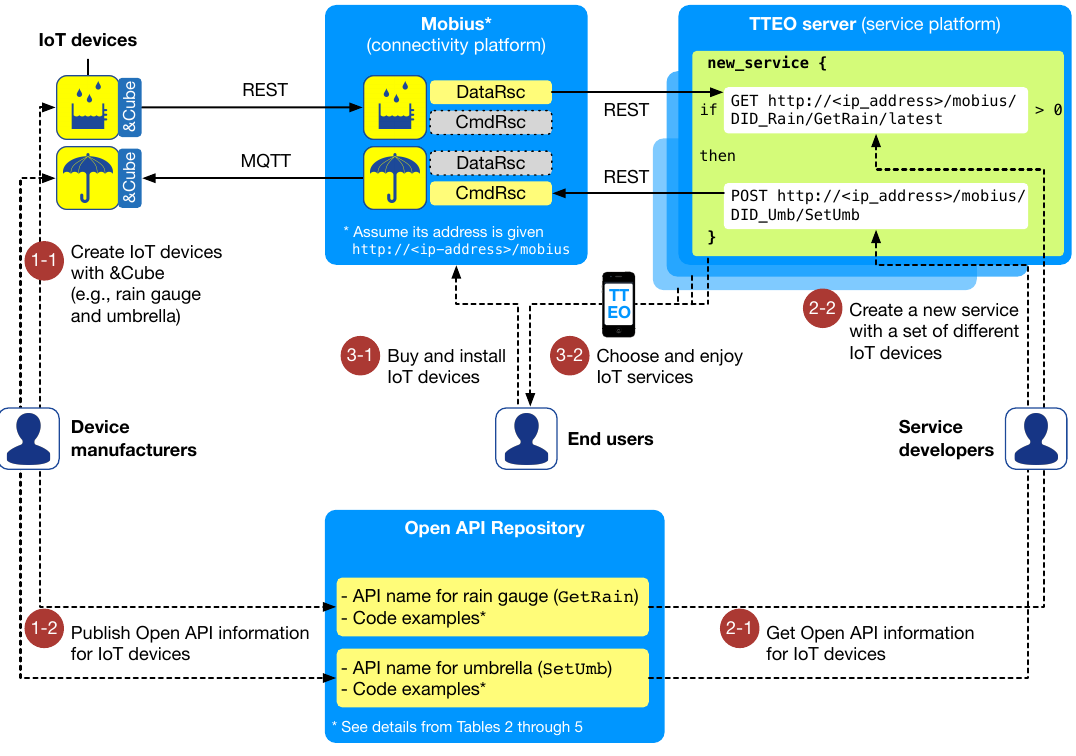
Figure 9. Ecosystem analysis of our approach from the perspectives of device manufacturers, service developers, and